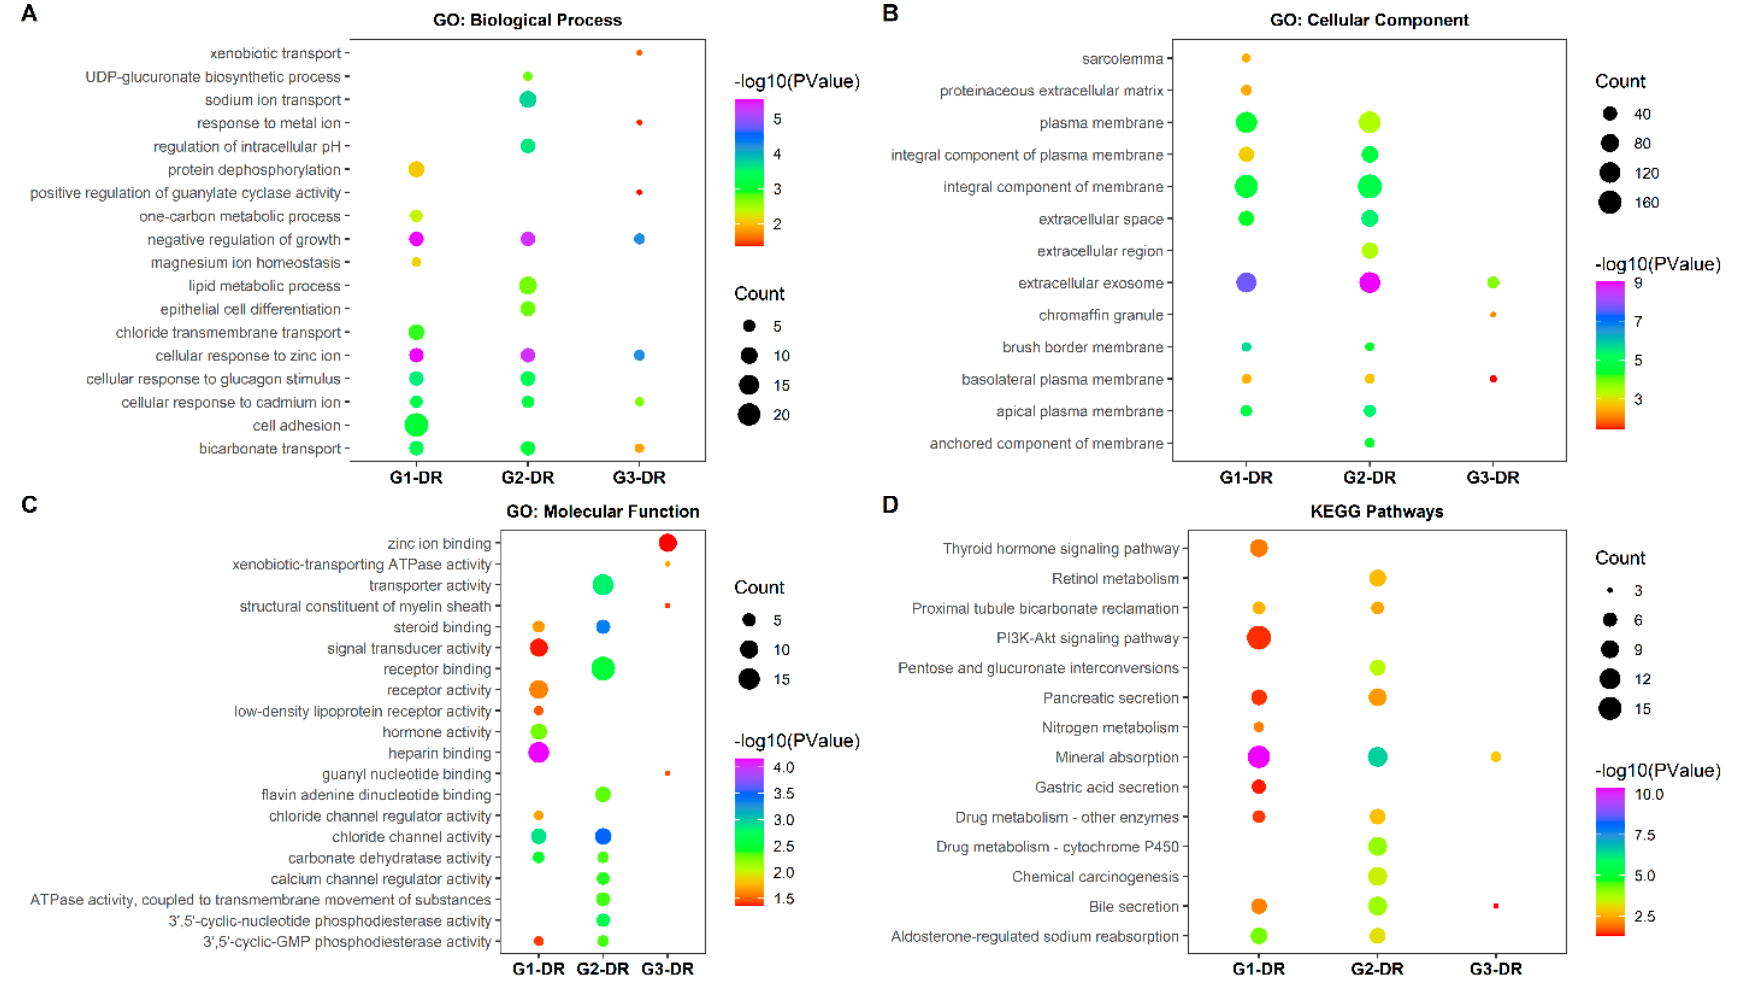
Figure 2. GO and KEGG pathway enrichment of RRA DR genes. ( A ) GO enrichment of biological process. ( B ) GO enrichment of cellular components. ( C ) GO enrichment of molecular function. ( D ) KEGG pathway enrichment. Abbreviations: DR, downregulated.